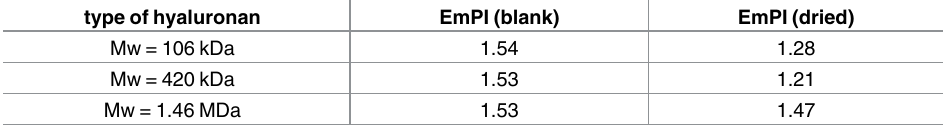
Table 3. Ratio of the first (373 nm) and third (383 nm) vibronic peaks in the scan for samples with pyr- ene as a fluorescence